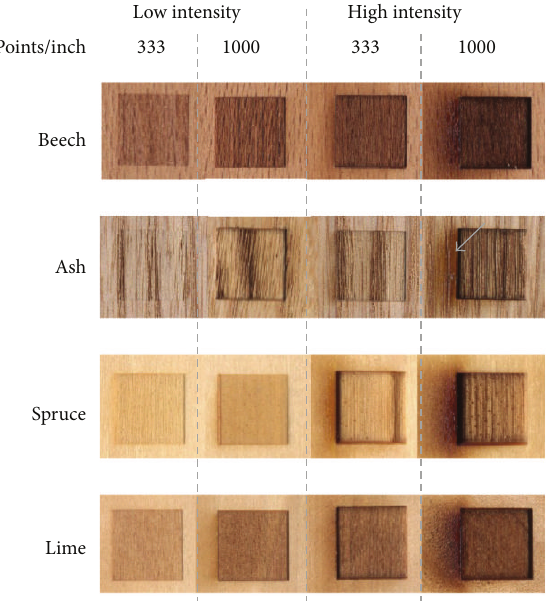
Figure 1: Images of laser treatments on the wood species with different laser intensities (a rectangular field of 10mm × 10mm was irradiated with the laser) from up to bottom, beech, ash, spruce, and